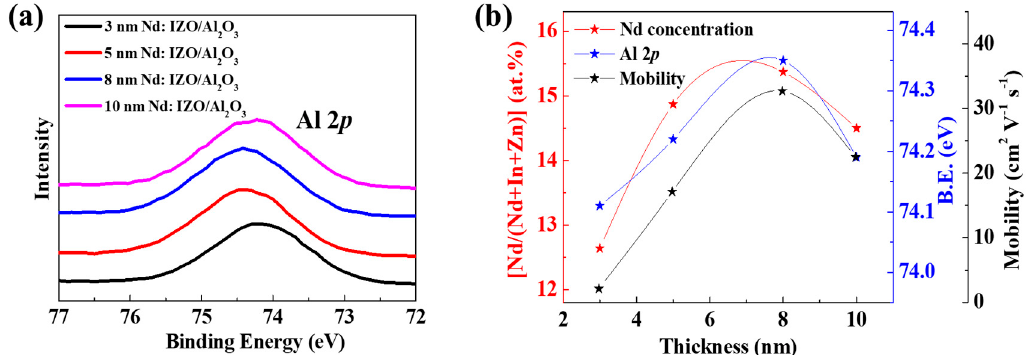
Figure 6. The ( a ) Al 2 p core level spectra of the Nd:IZO/Al 2 O 3 stacked films with different Nd:IZO thickness, and ( b ) its relationship with the Nd concentrations in Nd:IZO films and corresponding device mobility.